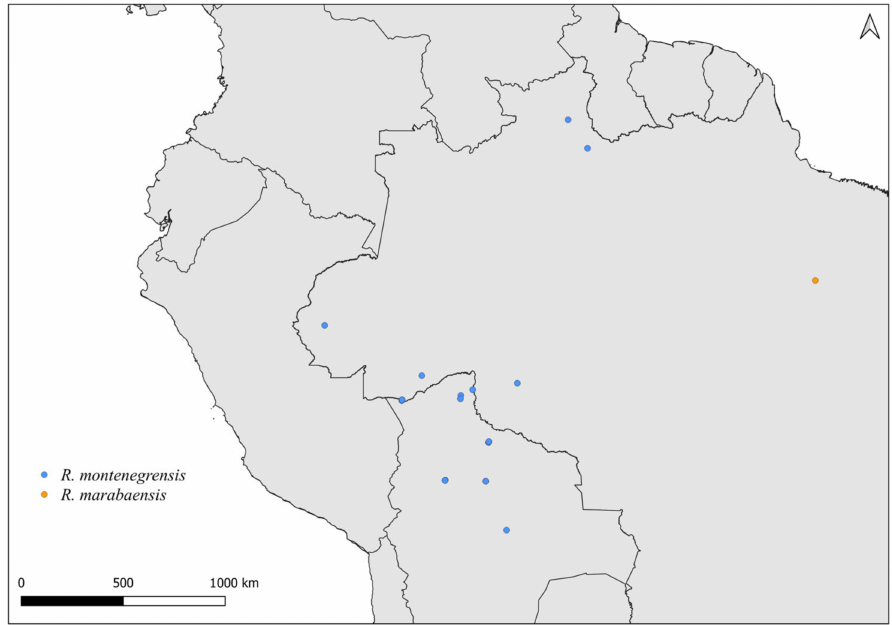
Figure 6. Distribution maps for R. montenegrensis and R. marabaensis